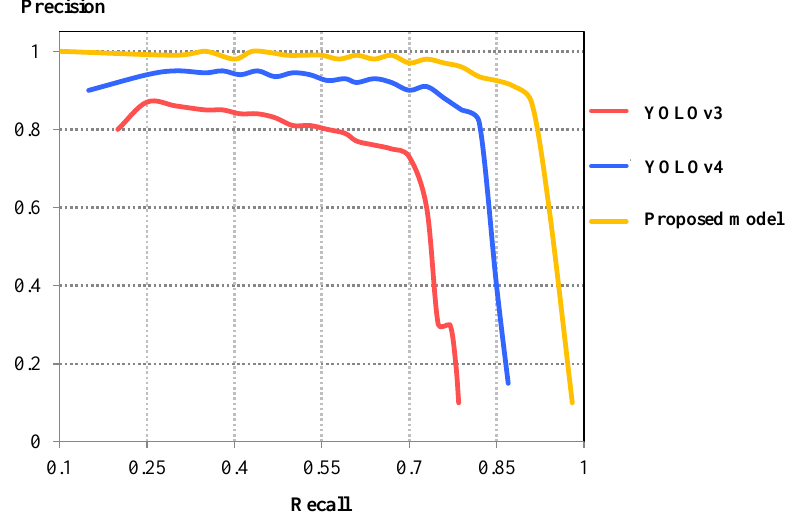
Figure 6. Comparison of P-R curves between YOLOv3, YOLOv4, and proposed detection